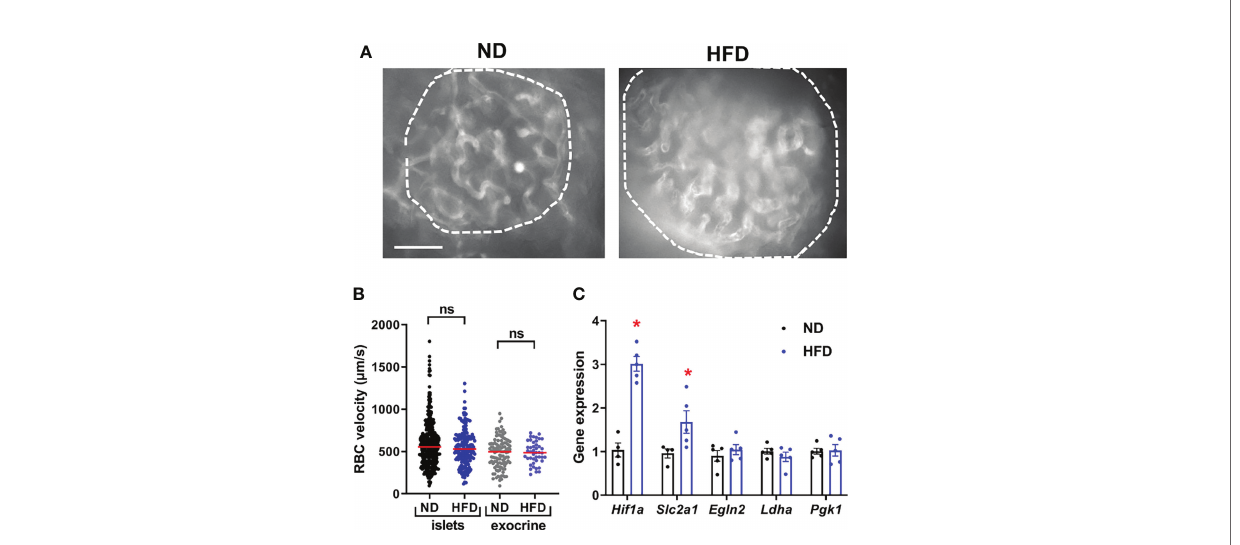
FIGURE 2 | Basal islet blood fl ow remains unchanged following HFD despite islet hypoxia. (A) Still images from an in vivo movie of blood fl ow depicting an islet in a mouse fed with normal diet (ND) or high-fat diet (HFD) (See also Video S1 ) (scale: 50 µm). Vessel parenchyma was labeled with D2-dextran. Islets are circled. (B) Quanti fi cation of red blood cell (RBC) velocity in control (ND) and HFD-fed mice. Data is presented as mean ± SEM (n= 3-6 mice/condition, 5-10 vessels/mouse, One- way ANOVA). (C) Expression of hypoxia markers in islets from normal diet (ND) and high-fat diet (HFD) fed mice were measured by RT-qPCR. Data were normalized by the geometric mean of Ppia, Aldo3, Mrlp32 and Tbp. Ct values and expressed as fold increase relative to ND-fed control. Data is presented as mean ± SEM (n=4-5 separate mice/group, Mann-Whitney). *P < 0.05. ns, not signi fi